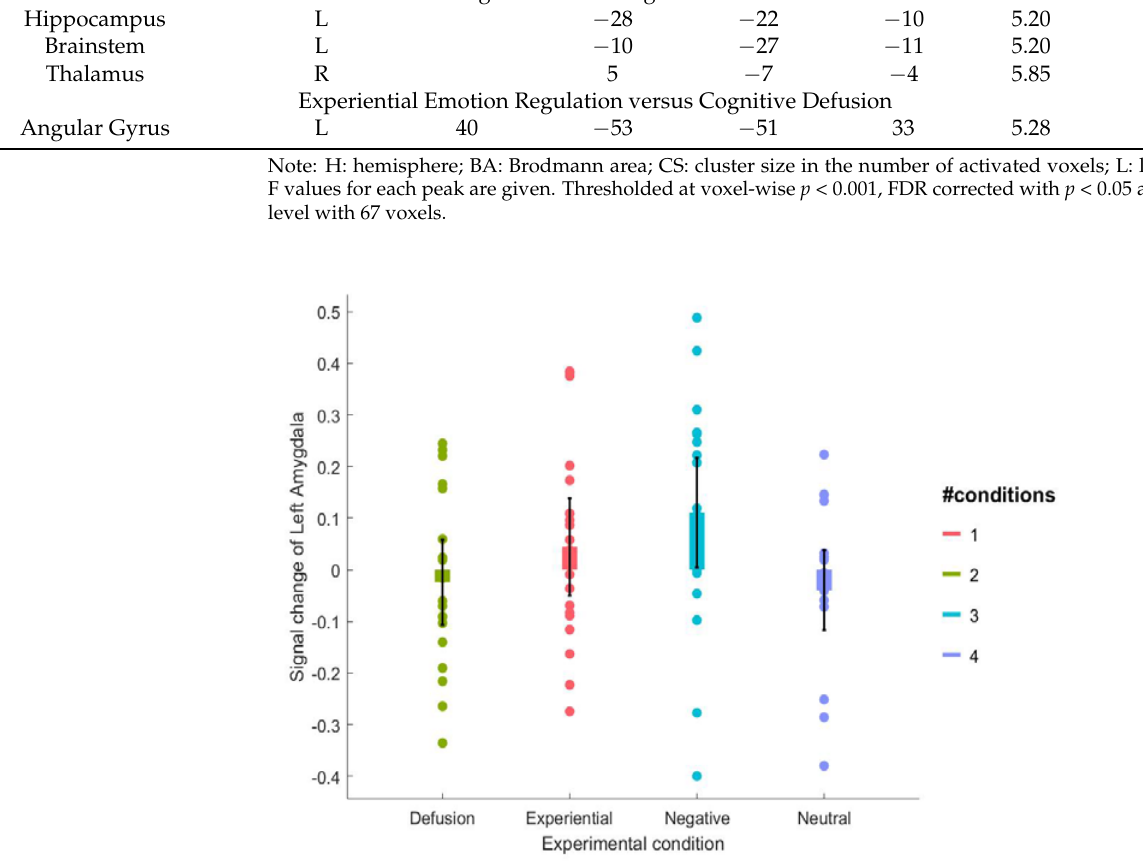
Table 5. Connectivity results from the generalized psychophysiological interactions (gPPI) analysis.